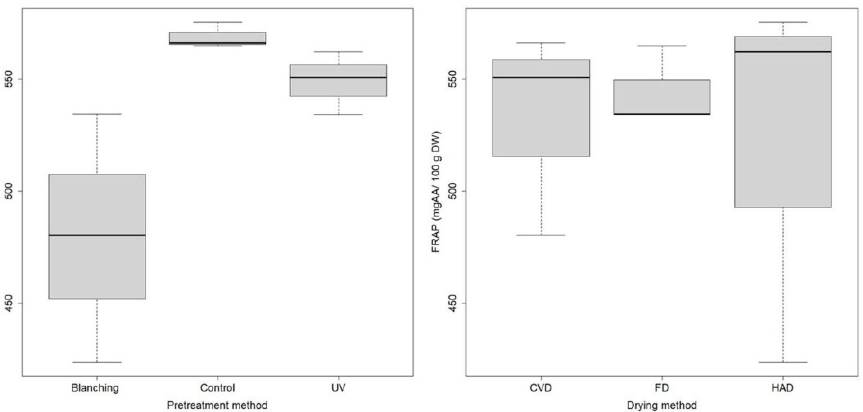
Figure 4. Boxplot of the TAA of B. edulis dried mushrooms in relation to pretreatment for all dried samples, and in relation to drying for all pretreated samples.